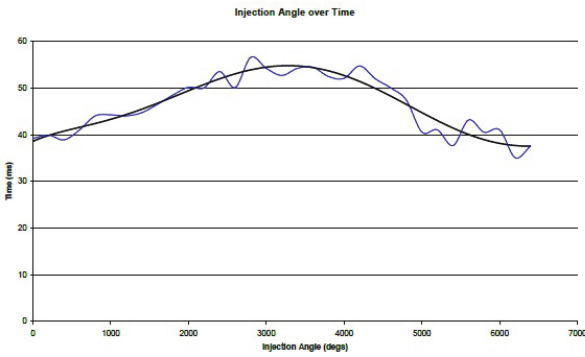
Figure 13: Variance in needle vector angle during VP process from a video recording of a typical peripheral venepuncture application.